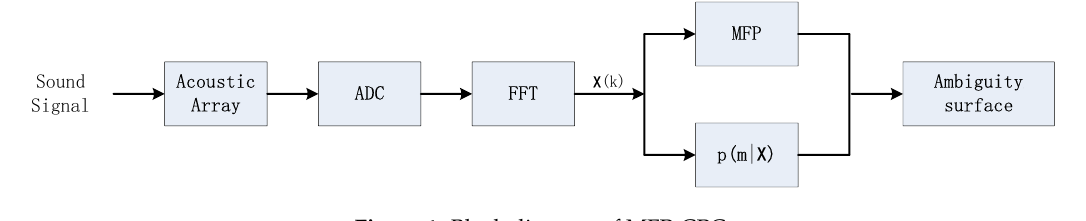
Figure 1. Block diagram of MFP-CPC.